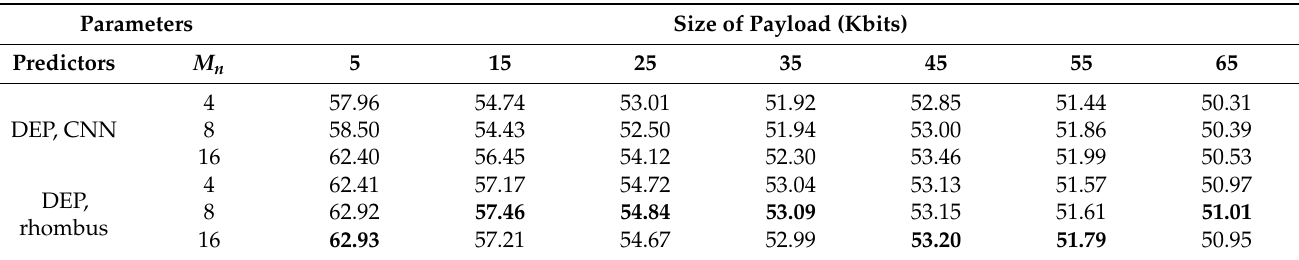
Table 1. Comparison of average PSNRs (dB) with different parameter configurations. The best performance is marked in bold.